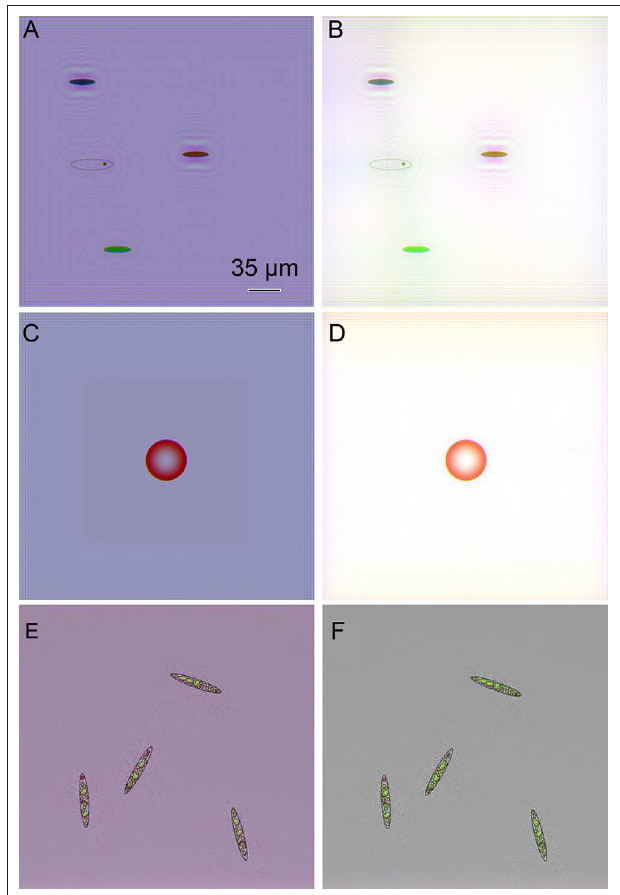
FIGURE 4 | Amplitude reconstructions of simulated objects from Figure 3 . Scale bar applies to all panels. (A) Colored ovals (B) Colored ovals with white balance correction. (C) Red sphere. (D) Red sphere with white balance correction. (E) Complex simulated Euglena . (F) Complex simulated Euglena with white balance